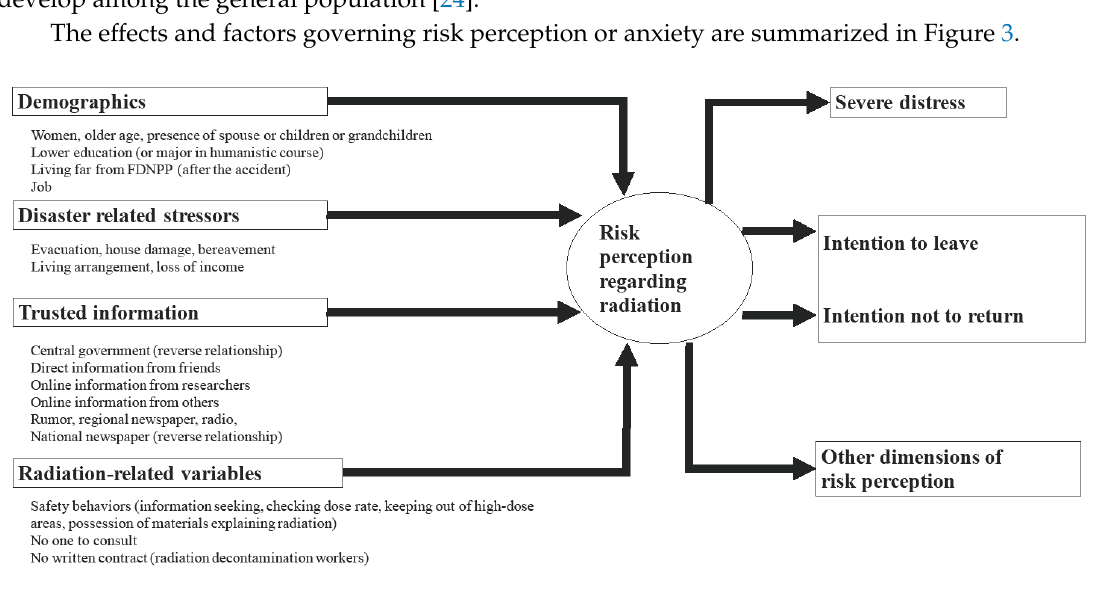
Figure 3. Contribution of risk factors to outcomes of risk perception or anxiety regarding radiation.